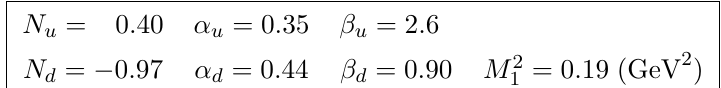
Table 2. Best values of the (cid:12)t of the Sivers functions. Table from ref.